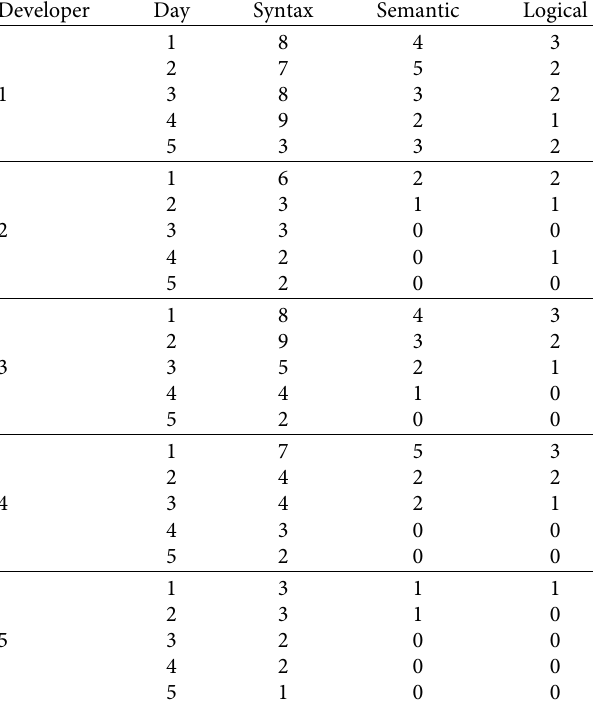
Table 8: Number of repetitive mistakes of 5 developers.